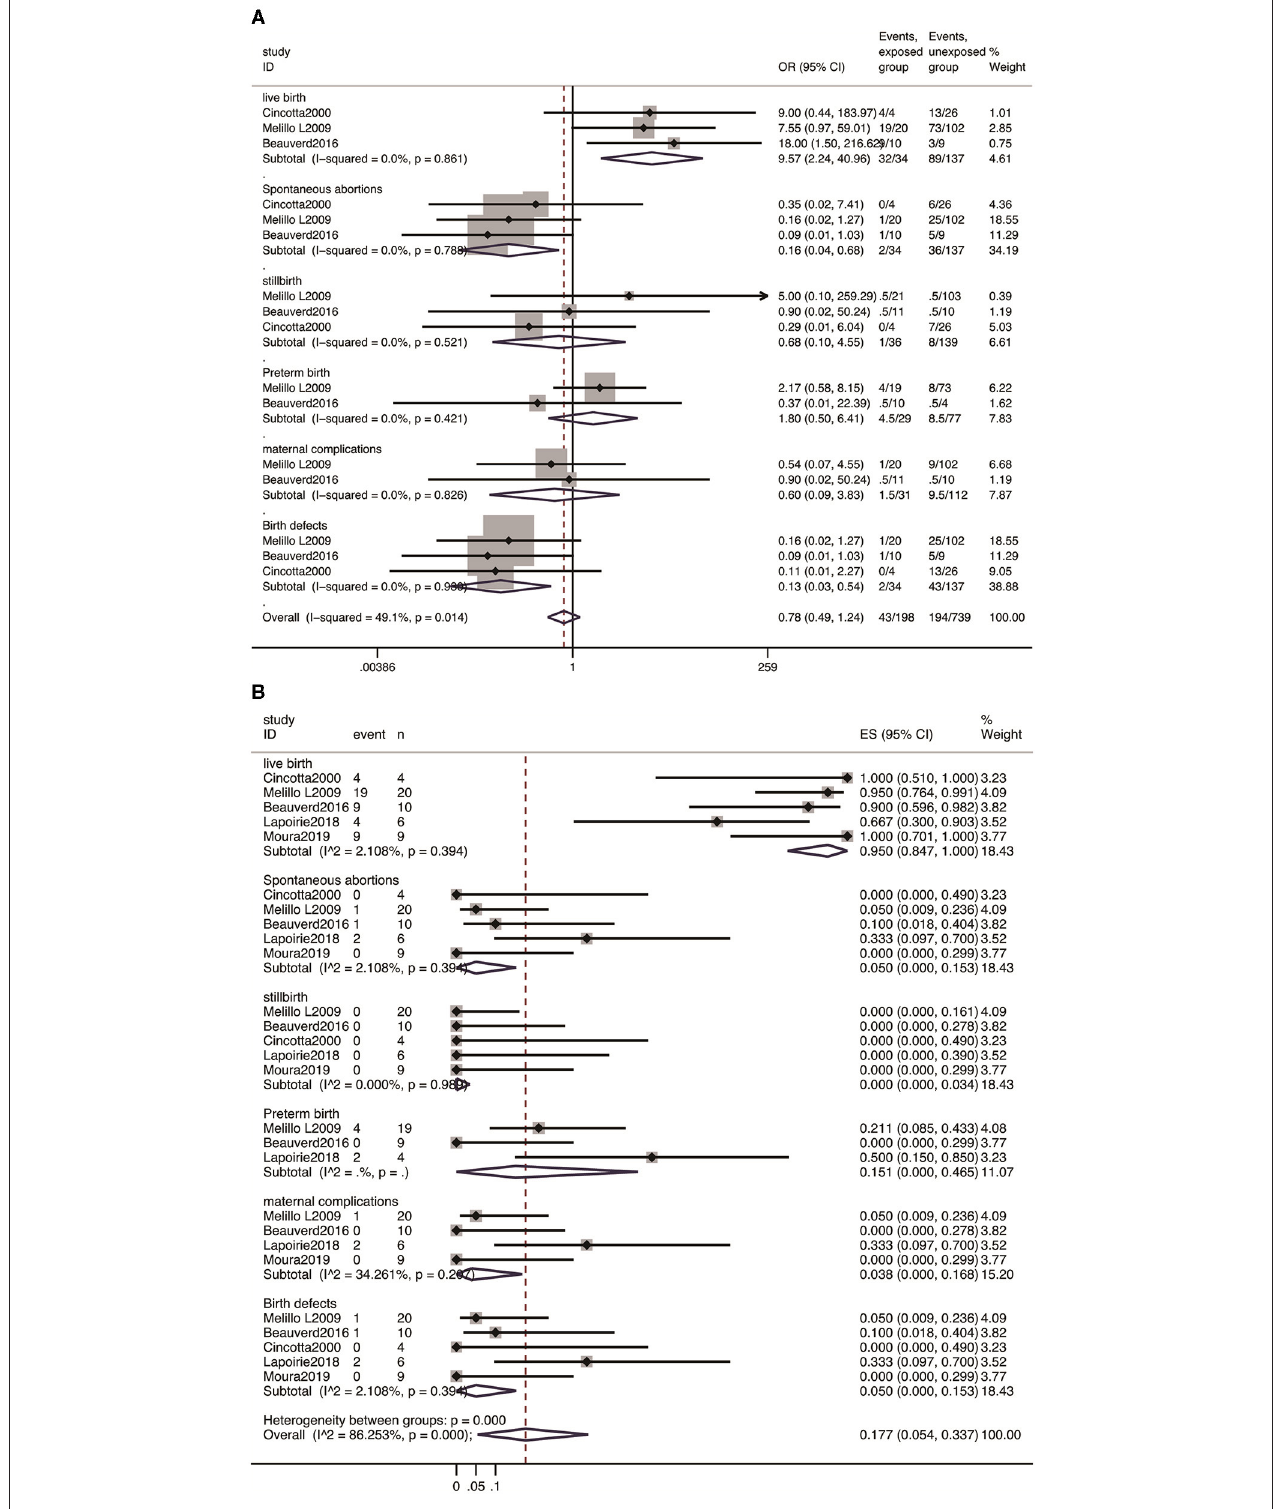
FIGURE 2 | Meta-analysis of pregnancy outcomes with IFN- α exposure. (A) The OR of pregnancy outcomes in IFN- α -exposed group compared with un-exposed group; (B) the pooled rate of each pregnancy outcome in IFN- α -exposed patients.